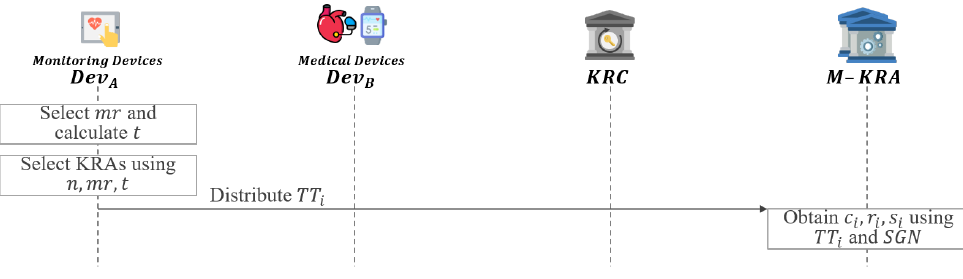
Figure 7. KRA fault recovery phase of proposed